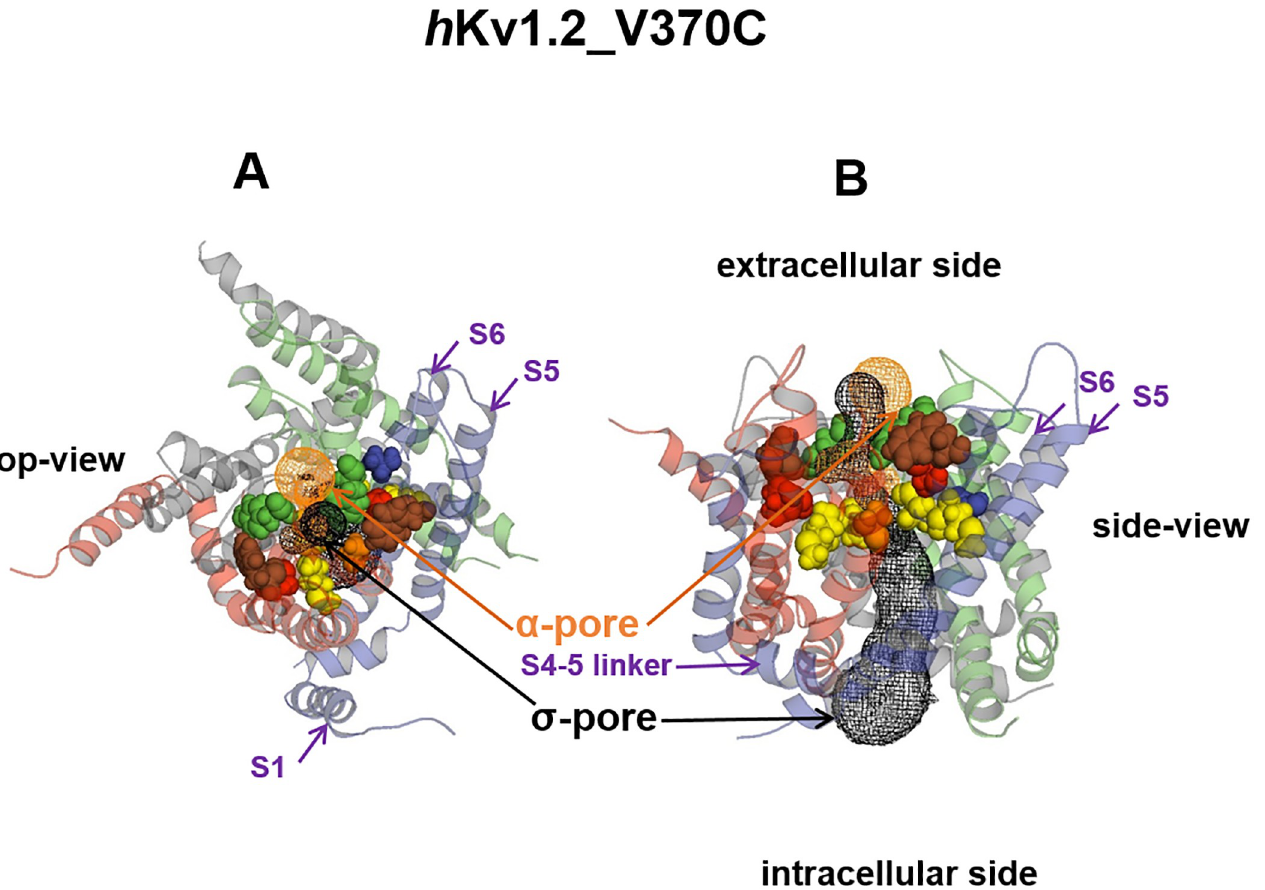
Fig 5. Proposed σ -pore pathway through the h Kv1.2_V370C mutant channel. The σ -poreis shown in black, the α -poreis shown in brown.